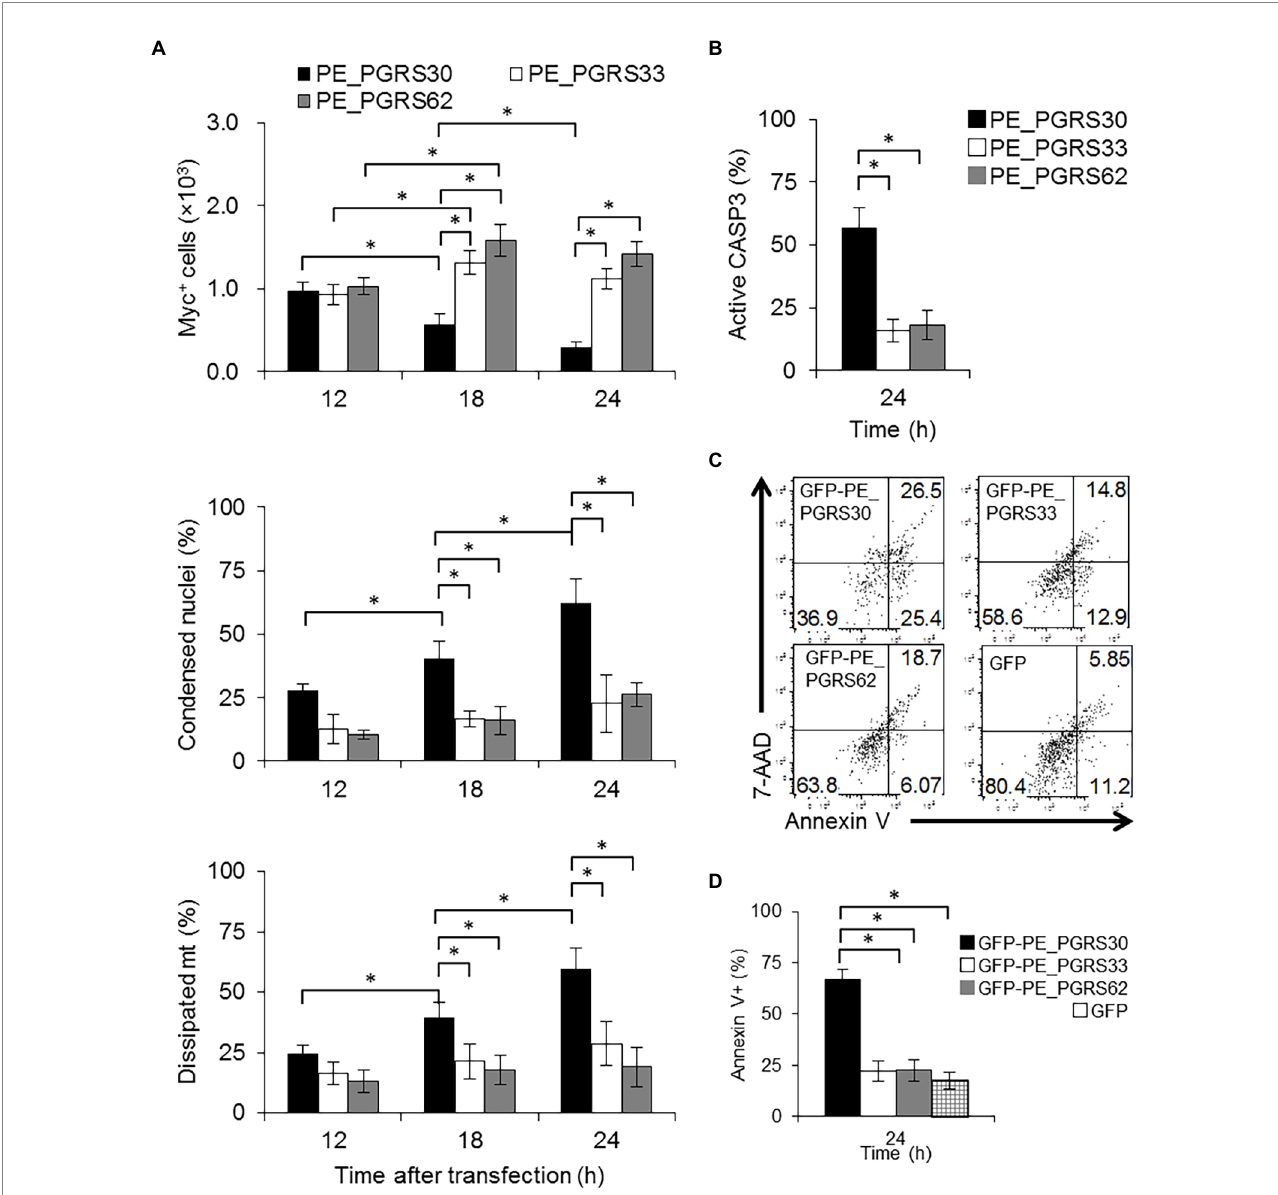
FIGURE 1 PE_PGRS30-expressing cells undergo apoptosis. (A) Status of cells expressing PE_PGRS protein. Numbers of cells expressing PE_PGRS protein after transfection (upper panel). Numbers of cells expressing PE_PGRS30-Myc, PE_PGRS33-Myc and PE_PGRS62-Myc proteins were counted at the indicated time points. Proportion of PE_PGRS-expressing cells with condensed nuclei (middle panel). Cells were stained with Hoechst 33342 at the indicated time points. Numbers of PE_PGRS-expressing cells with condensed nuclei were counted and are presented as percentage against total PE_PGRS-expressing cell numbers. Proportion of PE_PGRS-expressing cells with dissipated mitochondria (lower panel). Cells were stained with MitoTracker Red CMXRos at the indicated time points. Numbers of PE_PGRS-expressing cells with dissipated mitochondria (mt) were counted and are presented as percentage against total PE_PGRS-expressing cell numbers. (B) Proportions of PE_PGRS-expressing cells with active caspase-3. Cells were stained with anti-active caspase-3 antibody 24 h after transfection. Numbers of PE_PGRS expressing cells with active caspase-3 (CASP3) were counted and are presented as percentages